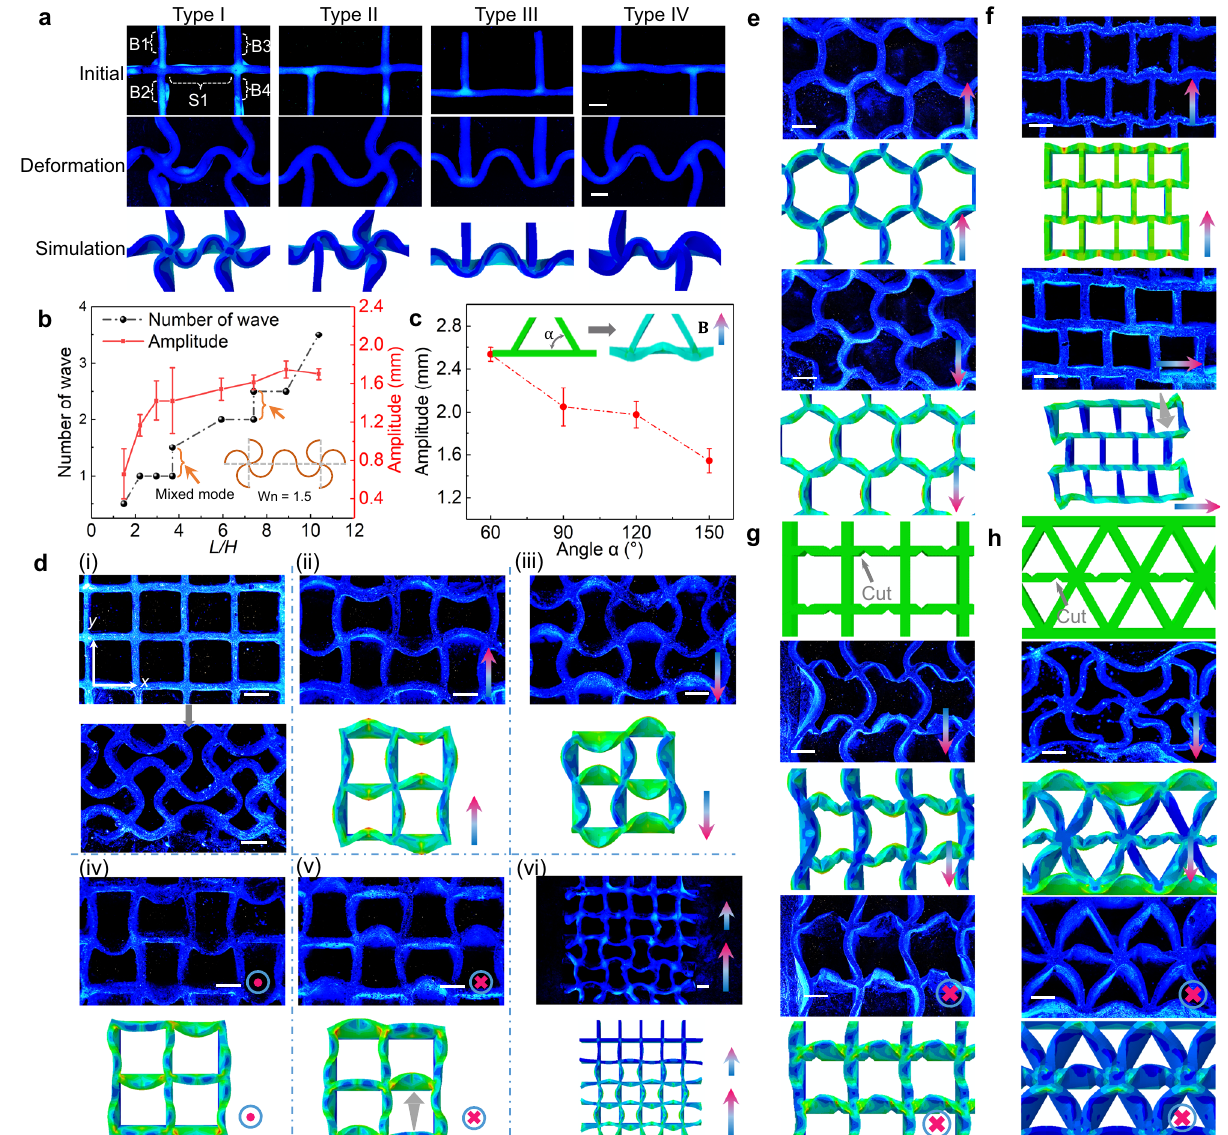
Fig.5|Impactofdifferentconnectivitytypesandgeometrictransformationof cellular structures. a Impact of four different boundary types on the buckled con fi gurationintheabsorptionofsolvent. b Thequantitativerelationshipbetween number of wave ( W n ), amplitude of the buckling structure and the dimensionless geometrical parameter ( L/H ) under magnetic stimulus. L is the distance between theconnectivitytypes,whichisthesameasthelengthofS1inFig.5a. H istheheight of the plate. W n represents the number of sinusoidal wave pattern generated in S1 and the inset schematic image shows the state that W n =1.5. As indicated by the orange arrow, mixed deformation modes are observed. c The quantitative rela- tionship between amplitude of the deformation results under magnetic stimulus